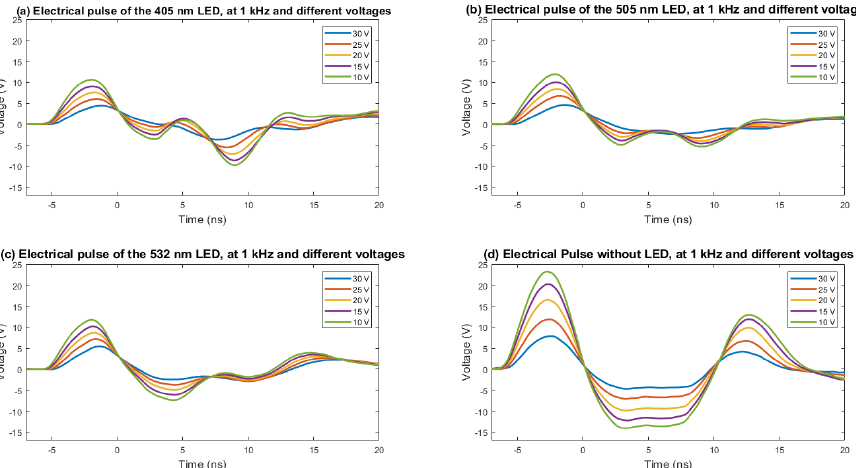
Figure 8. The electrical pulse is obtained with LEDs of 405 nm ( a ), 505 nm ( b ), and 532 nm ( c ). The electrical pulse without LED ( d ) is also presented. The pulses are presented for each LED, varying the voltage from 10 to 30 V in steps of 5 V and with a fixed frequency of 1 kHz.